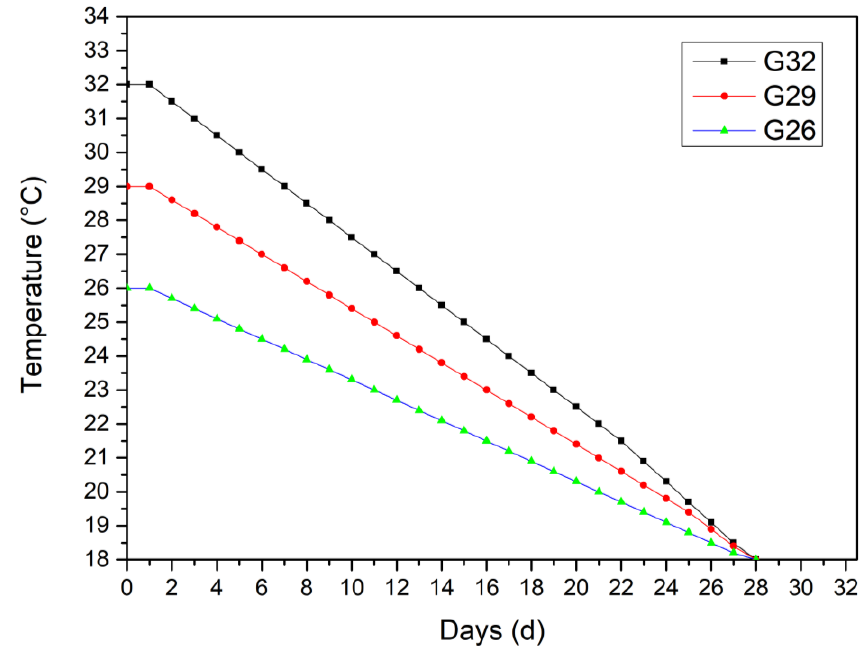
Figure 1. Temperature regime for gosling brooding at the first 4 weeks of age.